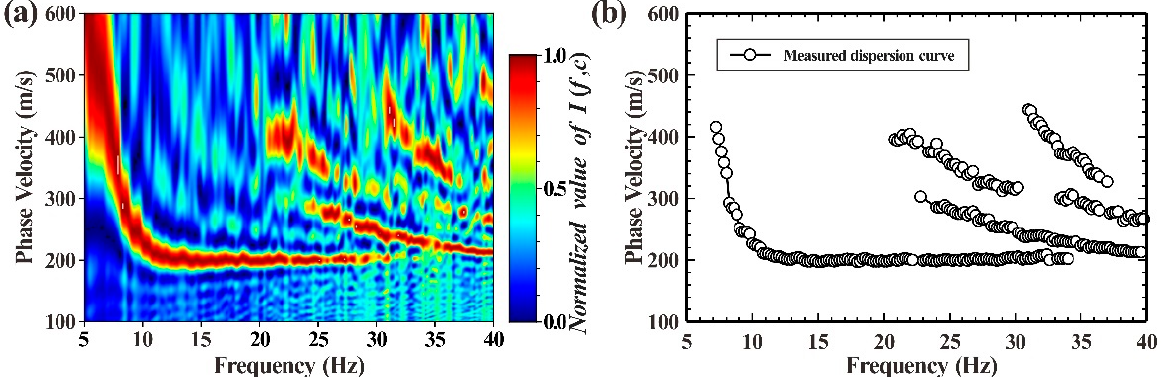
Figure 11. Dispersion diagram and detected measured dispersion curve obtained using frequency- Bessel transform after the combination of cross-correlation functions calculated by the two observation systems. ( a ) The dispersion diagram; ( b ) The detected measured dispersion curve.